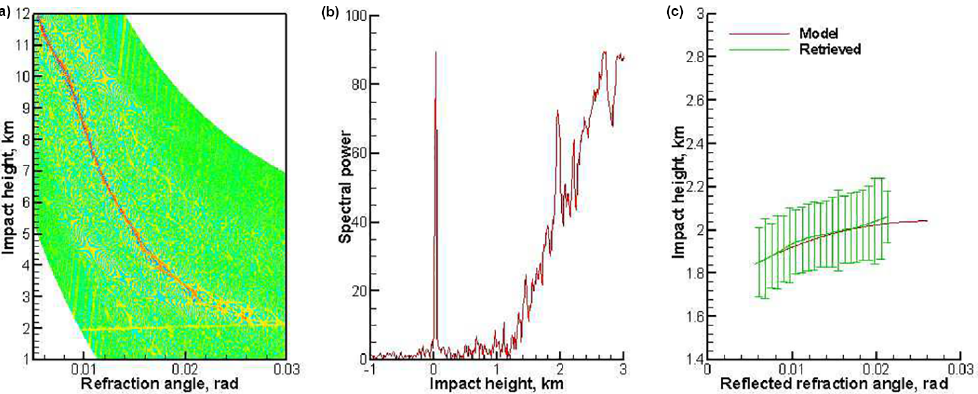
Figure 9. Occultation event 1 January 2008, 14:59:50UTC, 72.34 ◦ N 164.30 ◦ W. Expressed as a: (a) Wigner distribution function; (b) radio holographic spectrum; (c) model and retrieved reflection bending angles, the latter with error bars indicating the uncertainty estimate. Reflection index 27.2.